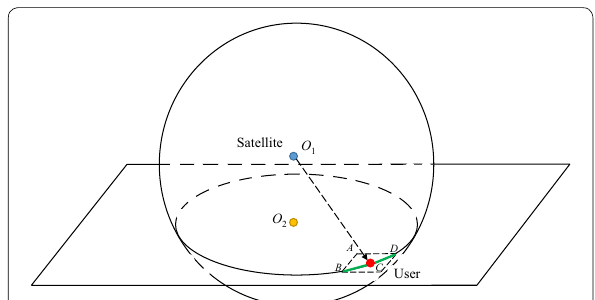
Fig. 2 When a user’s clock is known, a possible position of a user in two-dimensional search plane determined by a single satellite is the green arc that is the intersection of the search range ABCD and circle O 2